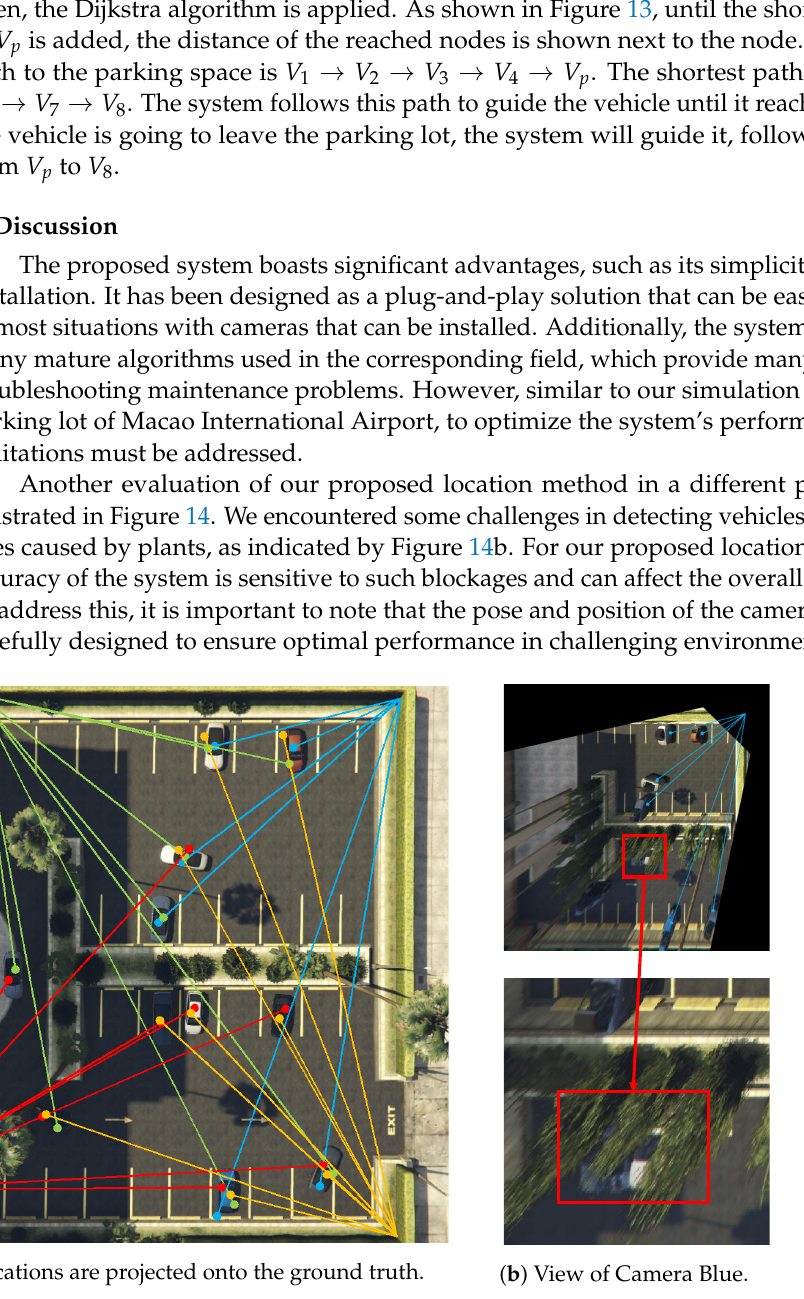
Figure 14. Evaluation of the proposed locating method in a challenging parking lot with cars and plants, demonstrating the effectiveness of the method in accurately locating the spatial coordinates of cars using the IPM. However, some objects may not be detected in some of the views. ( a ) shows all cameras could reflect most objects’ locations well. ( b )shows some objects are not